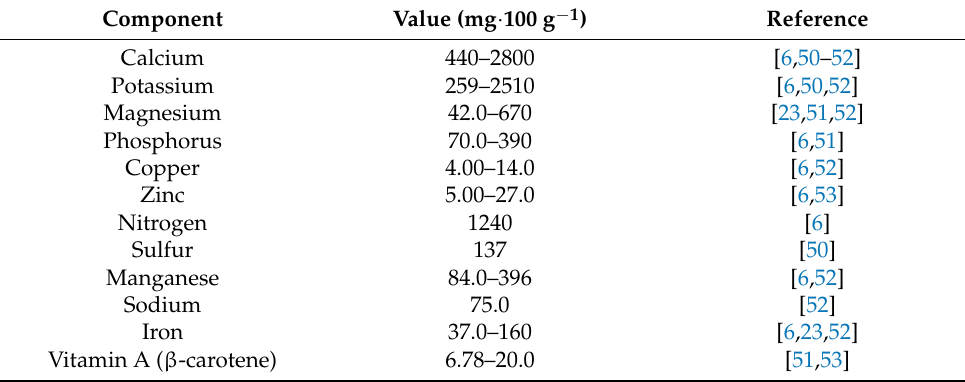
Table 1. Nutrient composition of fresh moringa